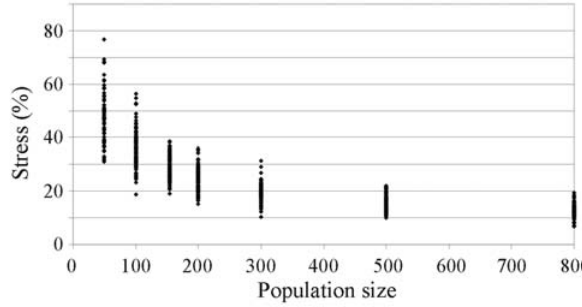
Figure 3 - Dispersion of stress coefficients for linkage group 1 as a func- tion of population size, simulated using a genome with marker saturation level of 5 cM. Stress was evaluated only in the replications that led to the formation of 11 linkage